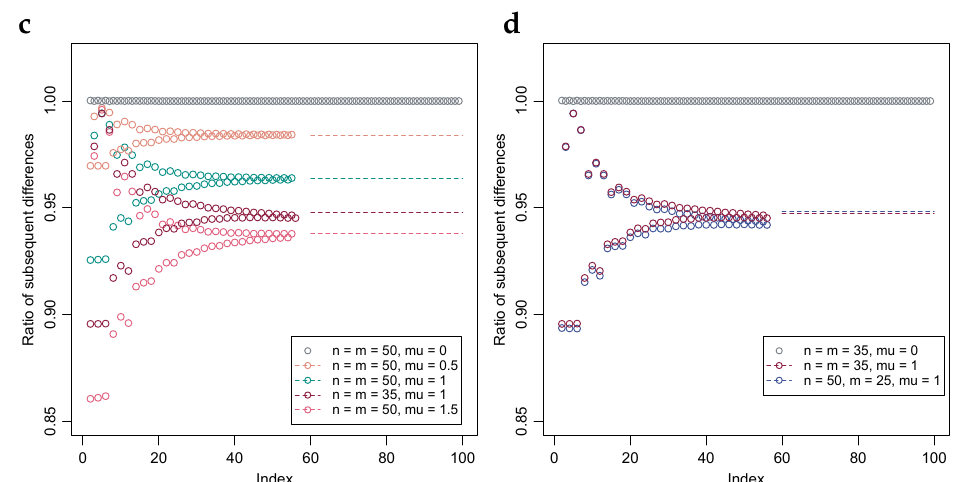
Figure 1. Exact probability distributions of the AUC-value under a range of parameters. ( a ) Exact computation and Monte Carlo estimation of the AUC-value distribution when TPs and TNs are 10 each and iid with normal distributions of equal variance and unit difference in mean. Inset, top 10 percentiles. ( b ) Exact computation and MC estimation of the AUC-value distribution when TPs and TNs are 50 each and iid normal with equal variance and unit difference in means. Geometric interpolation between exact computation and the MC estimated 99th percentile is included. Inset, top percentile. ( c ) Stability of the ratio of subsequent differences under a range of parameters, i.e., ( ∆ x i / ∆ x i − 1 ) / ( ∆ k i / ∆ k i − 1 ) , with solution through the bisection method included in dashed lines. ( d ) Plot similar to Subfigure ( c ), albeit with numbers of TPs and TNs selected such that their products are approximately equal, with two selections having equal numbers of TPs and TNs and the third twice the TPs relative to